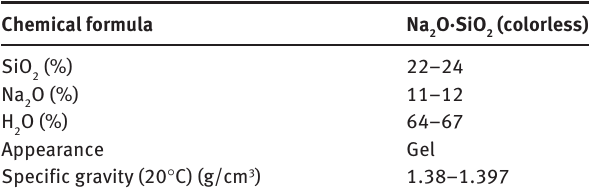
Figure 2 FRITSCH mill used for grinding the pumice.